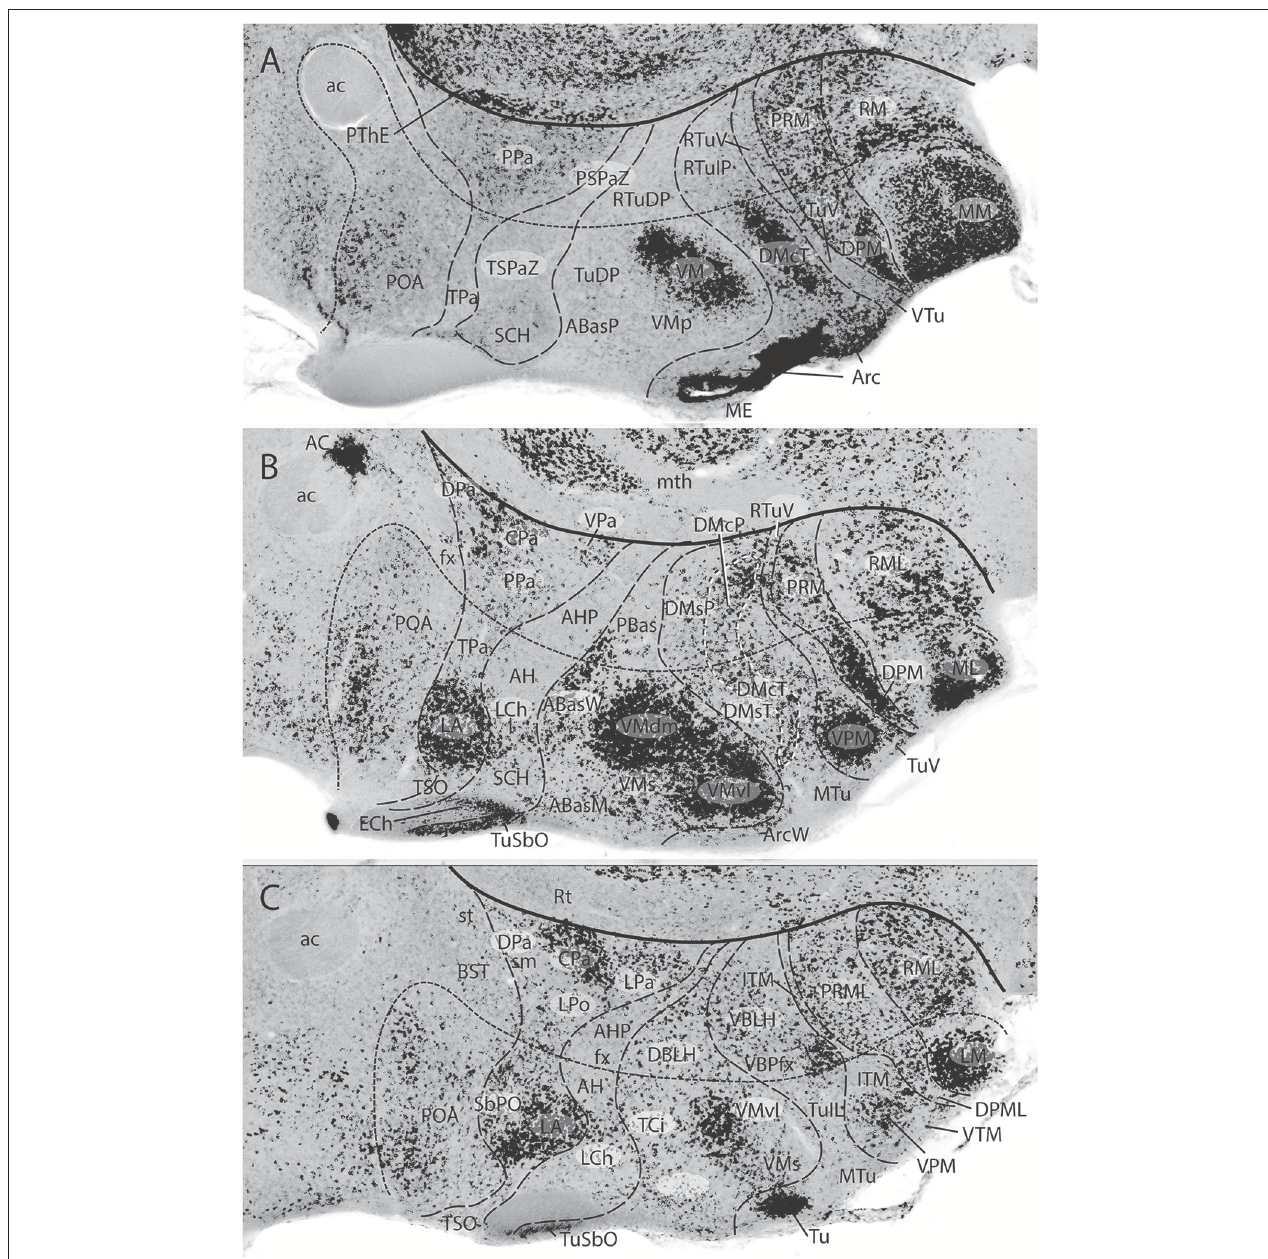
FIGURE 14 | Three sagittal sections through the adult mouse hypothalamus, shown in medio-lateral sequence (A–C) , which were in situ reacted for Glu2 , a gene marker of glutamatergic excitatory neurons (from Puelles L. et al., 2012a; no copyright permission required). The thick black line indicates the hypothalamo-diencephalic boundary (dorsal to the left; caudal to the top). The nearly parallel line with minute dashes is the intrahypothalamic segmental boundary that separates PHy from THy (or hp1 from hp2). Orthogonal dash lines separate alar and basal longitudinal progenitor domains. The images immediately make clear that the abundance of glutamatergic neurons is substantially higher at THy than at PHy A–C ; this is part of the evidence why these domains are considered different prosomeres; some columnar authors described similar compartments as “dorsal and ventral” hypothalamus regions, whereas some other columnar authors identified them as dorsoventrally related subthalamus and hypothalamus columns (the PHy contains the subthalamic nucleus in sections lateral to C ). Within the paraventricular alar area, numerous excitatory neurons appear aggregated at the lateral anterior nucleus (LA) within THy (B,C) ; there is also a dense patch selectively at the CPa subnucleus in PHy (C) . The subparaventricular area is largely devoid of this cell type (SCH, AH, AHP). The massive bipartite glutamatergic population within the VM hypothalamic complex (A–C) contrasts with the overall scarcity found at the neighboring DM formation, excepting the latter’s periventricular positive core population seen in (A) (probably migrated; DMcT, DMcP). The ventral and dorsal premamillary populations (VPM, DPM) also are largely excitatory (A,B) , as are the mamillary and retromamillary formations (MM, LM, RM, RML; A–C ). Note the subpallium found dorsal to the hypothalamus (e.g., POA) is generally poor in glutamatergic neurons, as is the reticular prethalamus (Rt; B,C ). In contrast, the prethalamic eminence only contains glutamatergic neurons (PThE; A ).